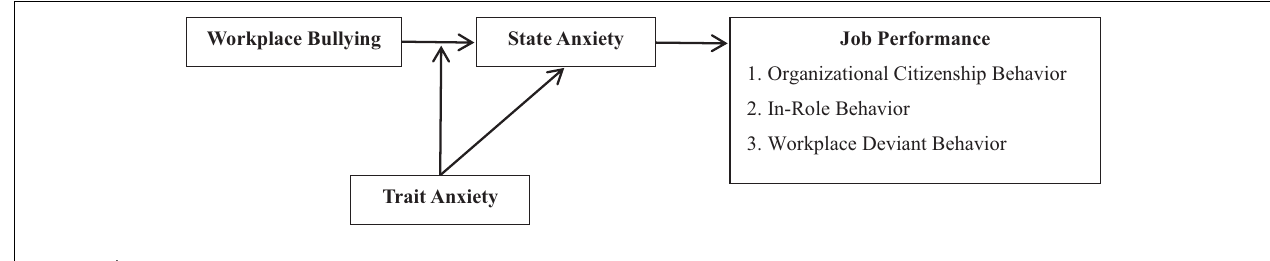
FIGURE 1 | Theoretical